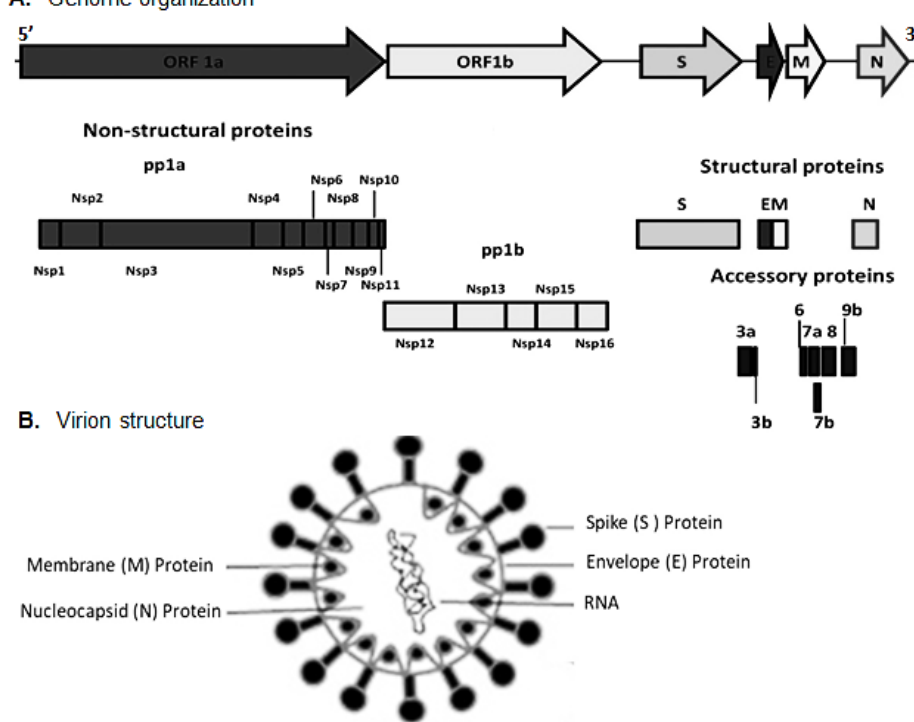
Figure 1. A graphic representation of the genomic and structural organization of SARS-CoV-2. (A) Genomic RNA showing the open reading frames (5’-3’) encoding non-structural replicase polyproteins (pp1a and pp1b) and their processed products, structural proteins (spike, S; envelope, E; membrane, M; and nucleocapsid, N) and accessory proteins (3a, 3b, 6, 7a, 7b, 8 and 9b). (B) virion structure. Adapted and modified with permission [12,